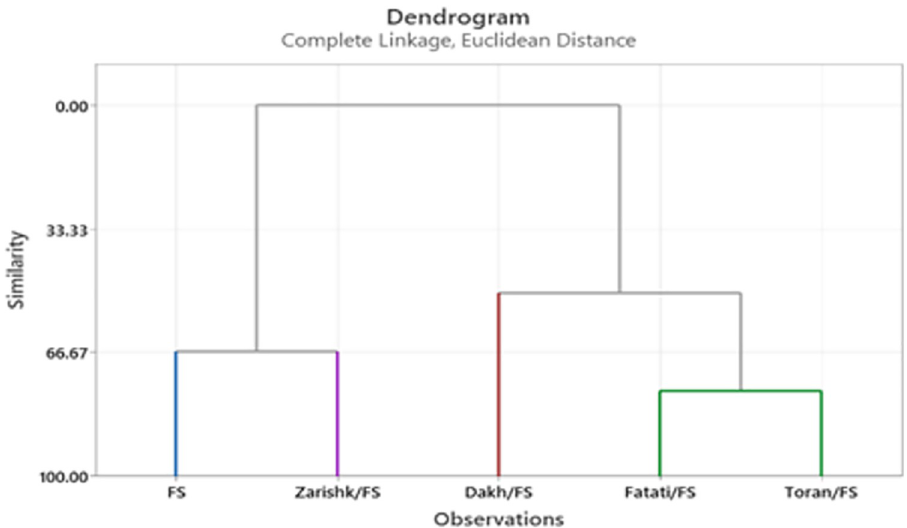
Fig 20. Dendrogram of cluster analysis of un-grafted and grafted Flame Seedless scion variety based on enzymatic and non-enzymatic biochemical traits under -8 bars of drought stress.